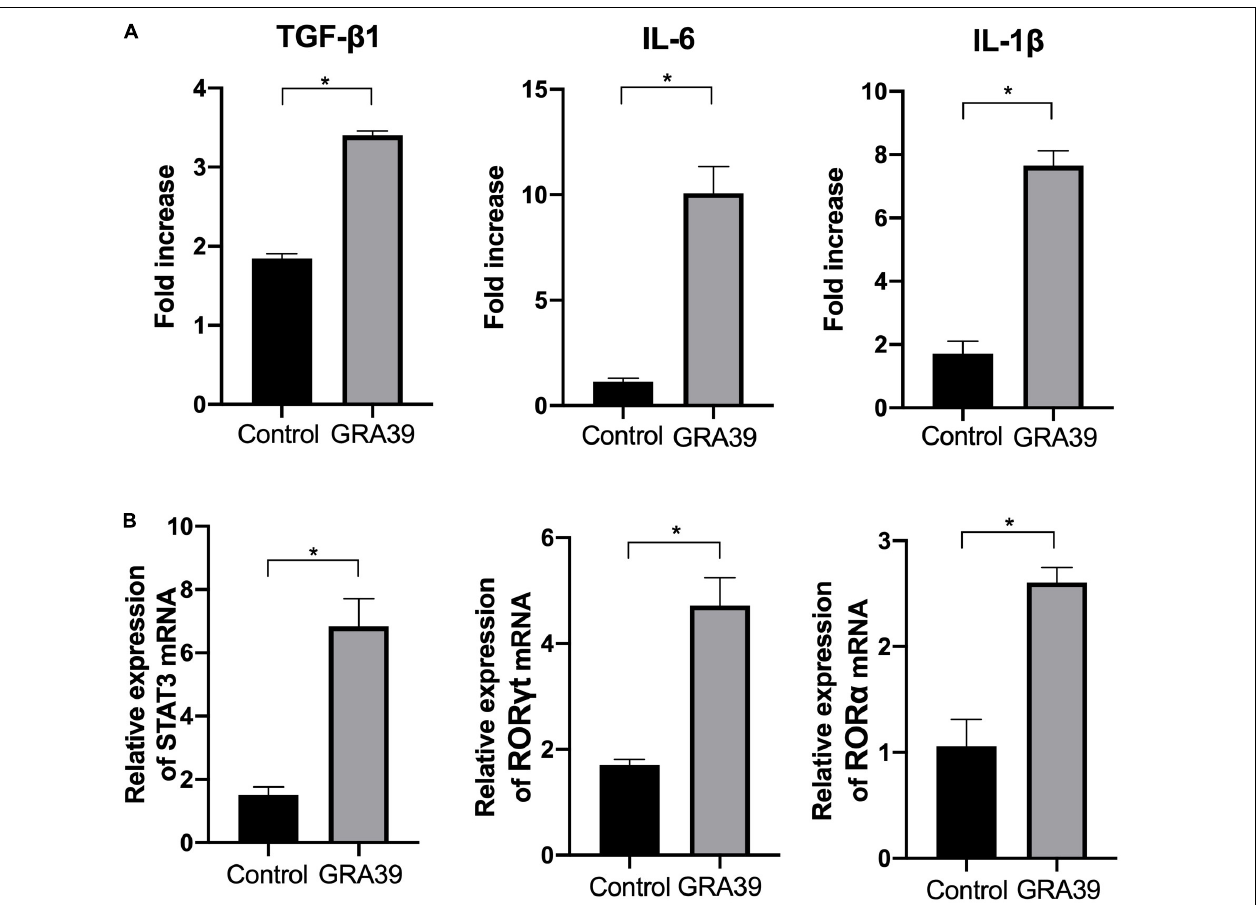
FIGURE 7 | Expression of the cytokines IL-1 β , IL-6 and TGF- β 1 and transcription factors ROR γ t, ROR α and STAT3. mRNA expression levels of IL-1 β , IL-6, TGF- β 1, ROR γ t, ROR α and STAT3 were measured in spleens from mice immunized with pVAX-GRA39, and expressed as fold increase over control. (A) The mRNA levels of IL-1 β , IL-6, TGF- β 1; (B) The mRNA levels of ROR γ t, ROR α and STAT3. Statistical differences are represented by *( p < 0.05).